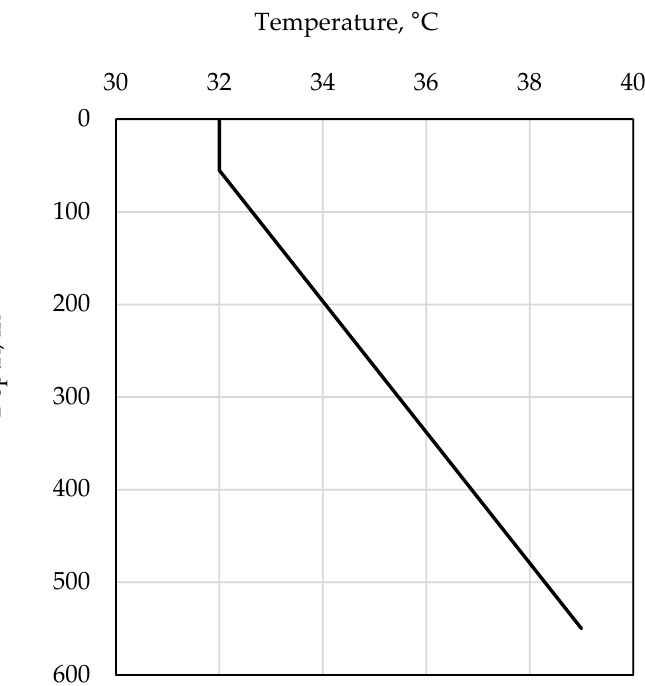
Figure 5. Temperature–depth profile on well/permafrost interface.